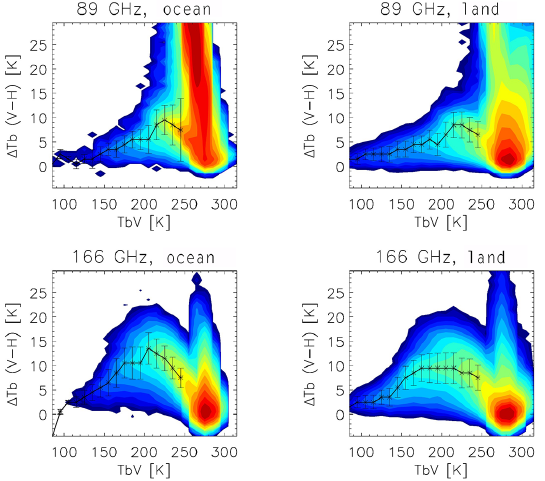
Figure C1. Same as Fig. 3, except for the [45, 55 ◦ ]N latitudinal belt.